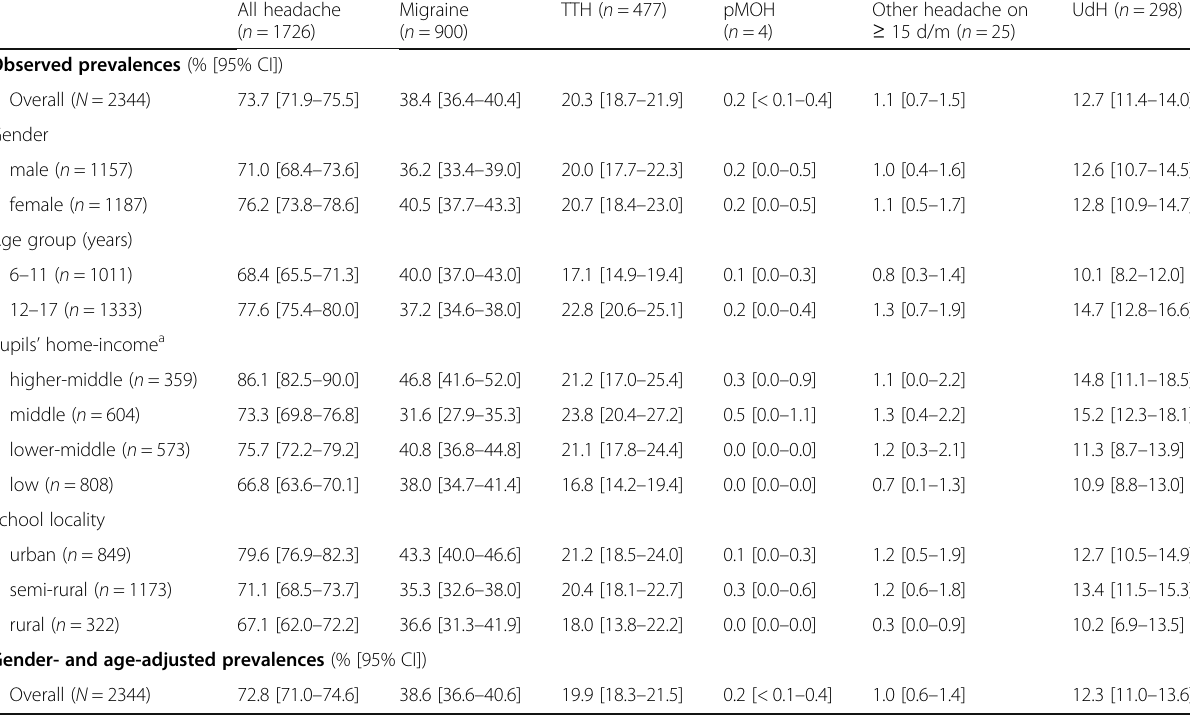
Table 2 Crude (observed) 1-year prevalences (% [95% CIs]) of all headache and each headache type, overall and according to demographic variables, and gender- and age-adjusted prevalences